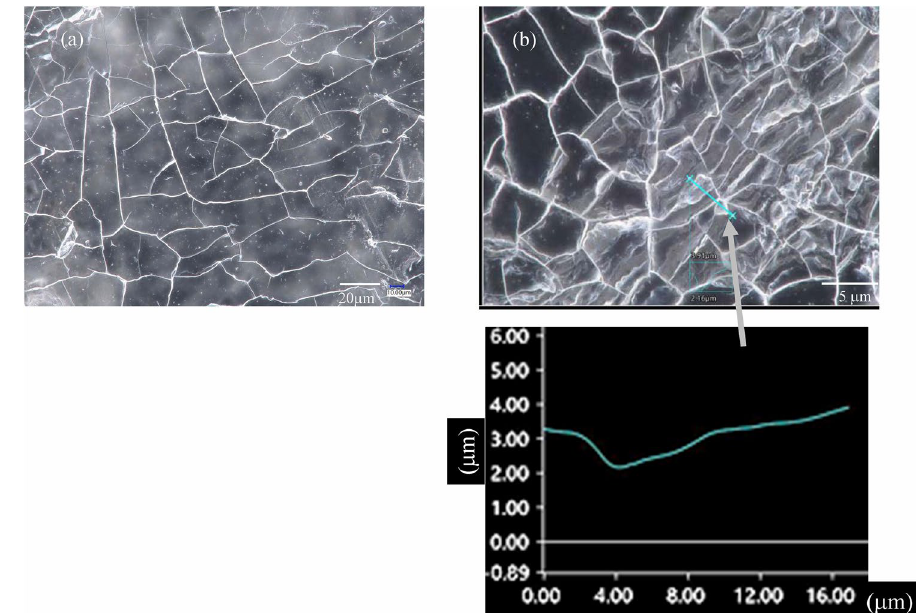
Fig. 7 Optical SEM micro- graph and 3D image of AOP degraded PP with heat pretreatment: AOP degrada- tion time = 9 days. a Before surfactant treatment. b After surfactant